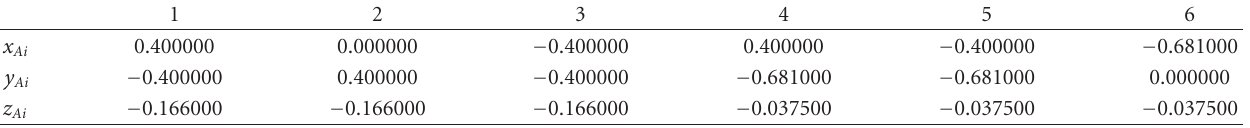
Table 2: The parameters of the moving platform which are measured in the coordinate frame O (cid:2) − uvw (m).